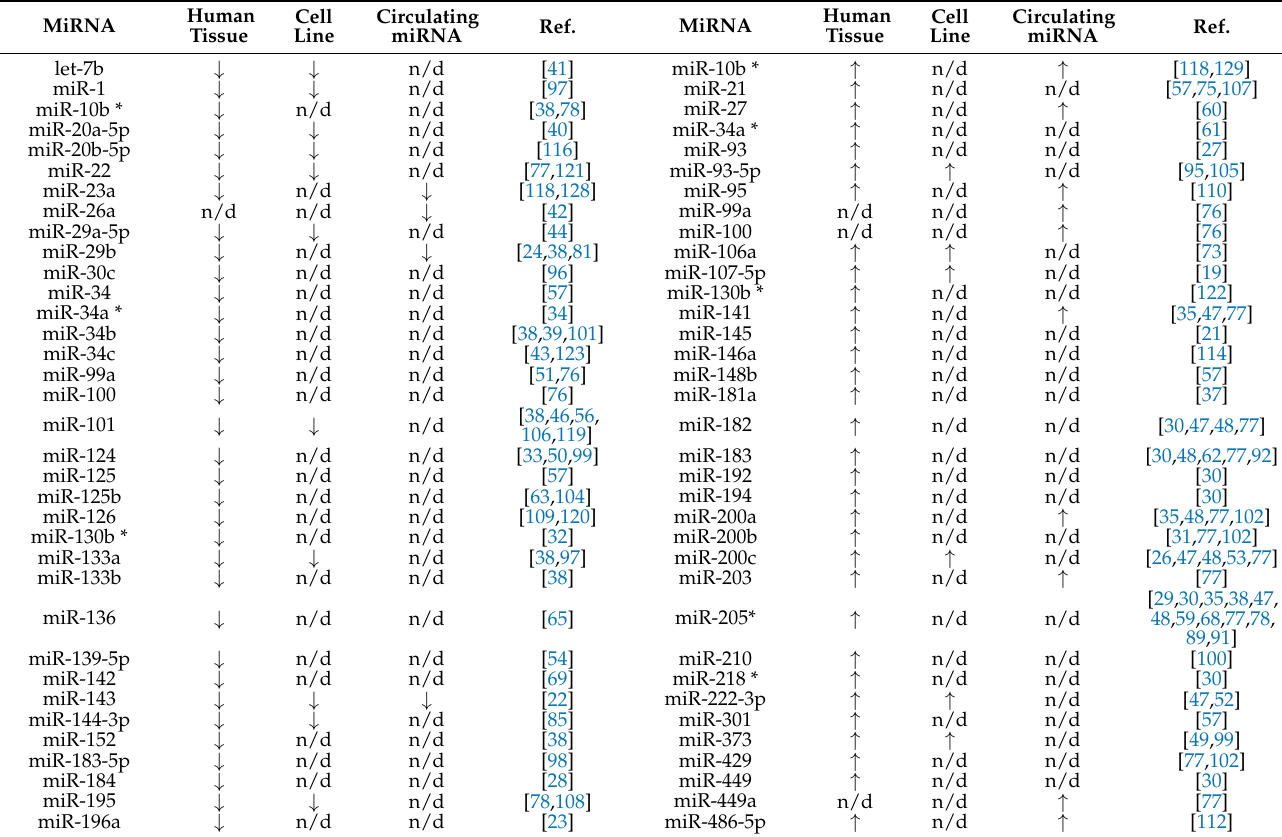
Table 2. Dysregulation of expression of invasiveness-associated miRNAs in endometrial cancer. Circulating MiRNA Human Tissue Cell Line miRNA